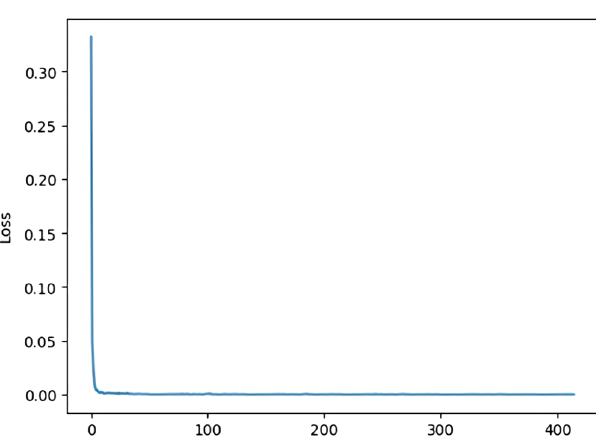
Figure 15. Change of autoencoder’s loss after five epochs of